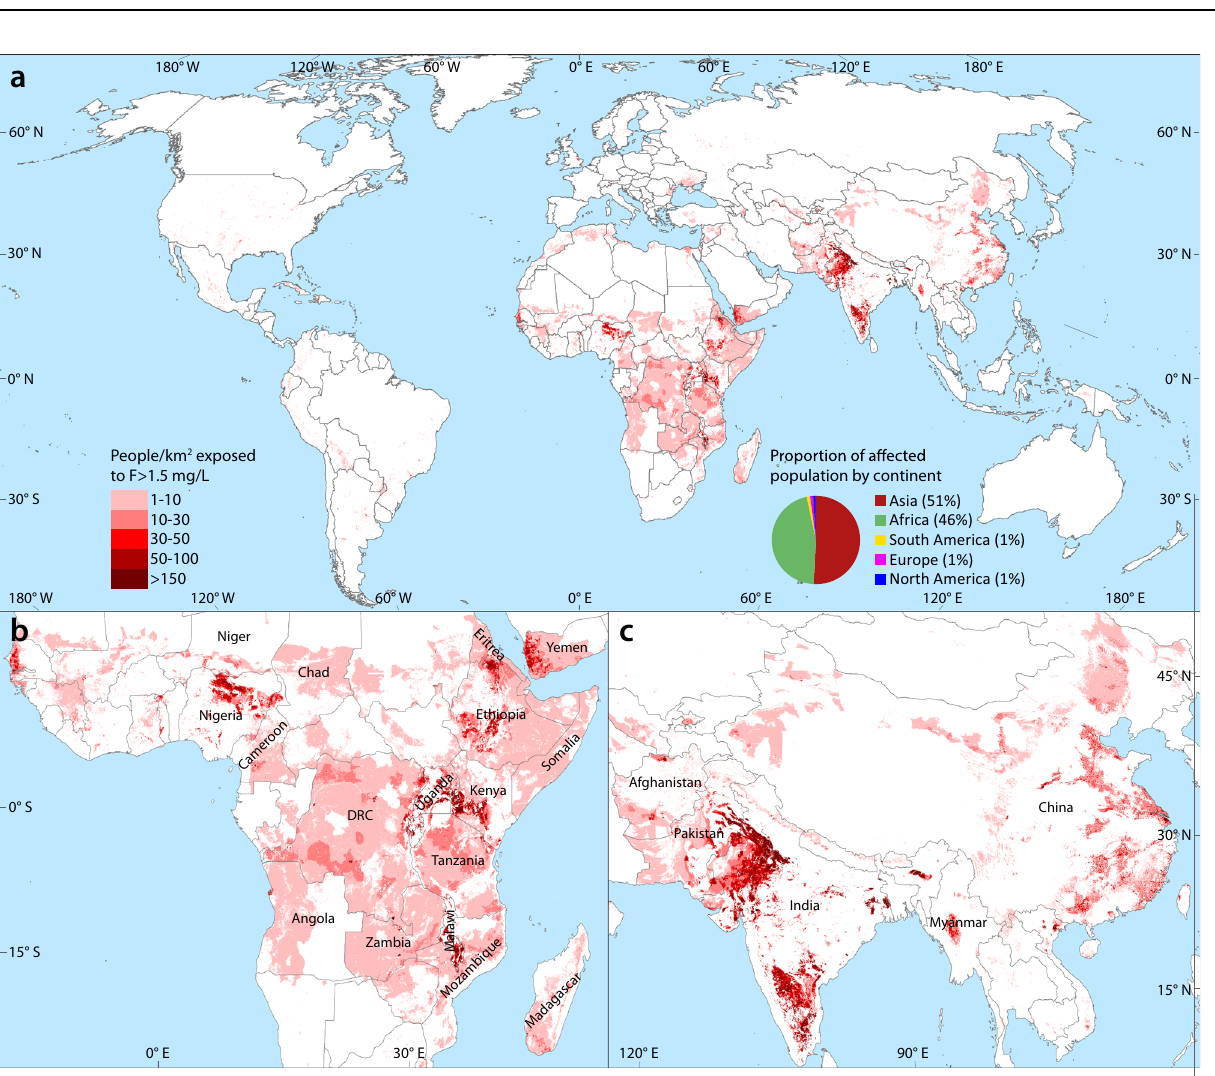
The fi rst number was calculated by multiplying the groundwater-consuming population of each cell by the probability of groundwater exceeding 1.5mg/L for cells with a probability >0.25 (hybrid approach). The range in parentheses is produced by the approaches of taking the full groundwater-consuming population of cells with a probability >0.50 (low estimate), as well as applying the probability to all map cells (high estimate).